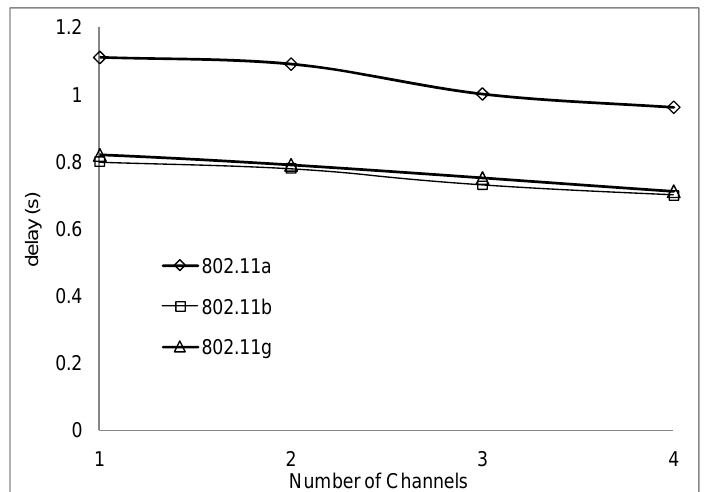
Figure 19. Delay occur at 100 m range and data rate of 2